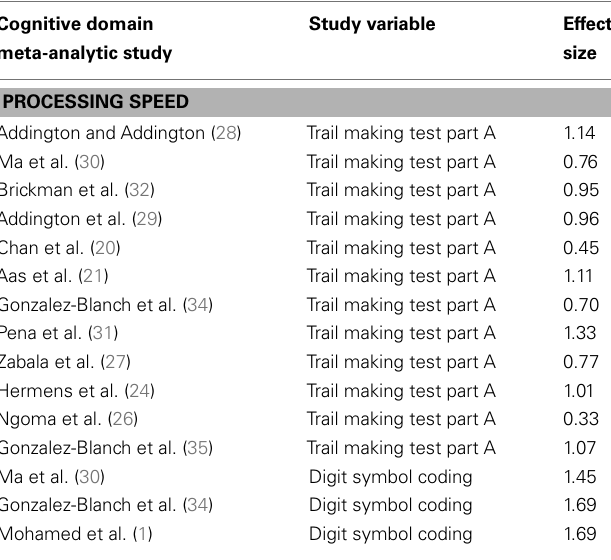
Table 4 | Studies comparing patients with first-episode psychosis and healthy controls on processing speed .